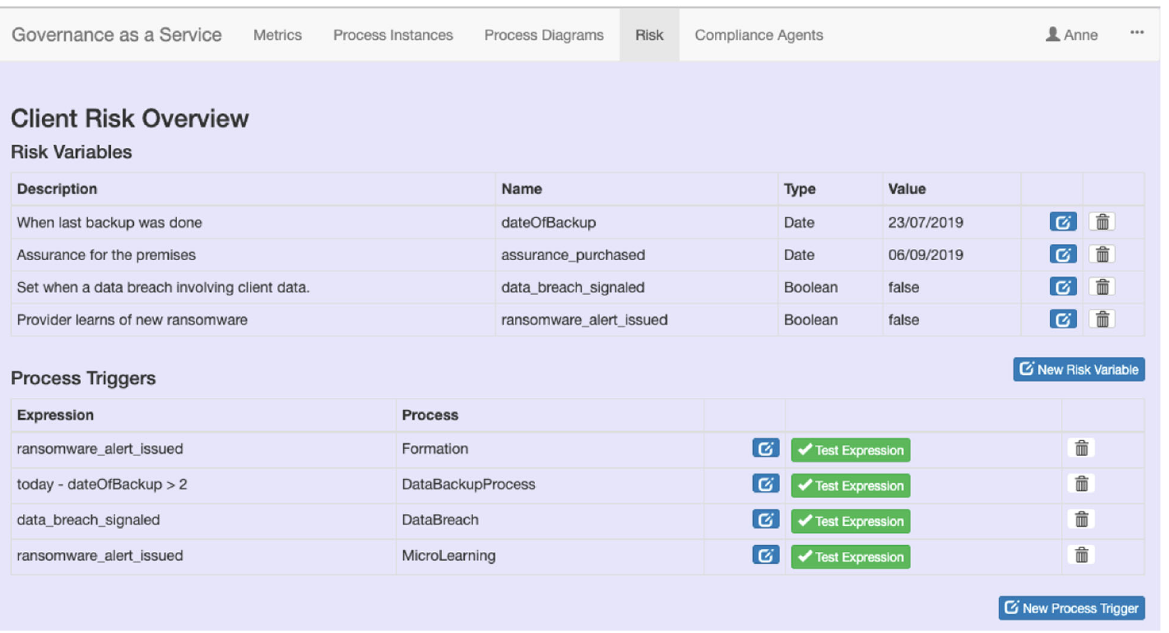
Fig. 3 Panel of the Governance